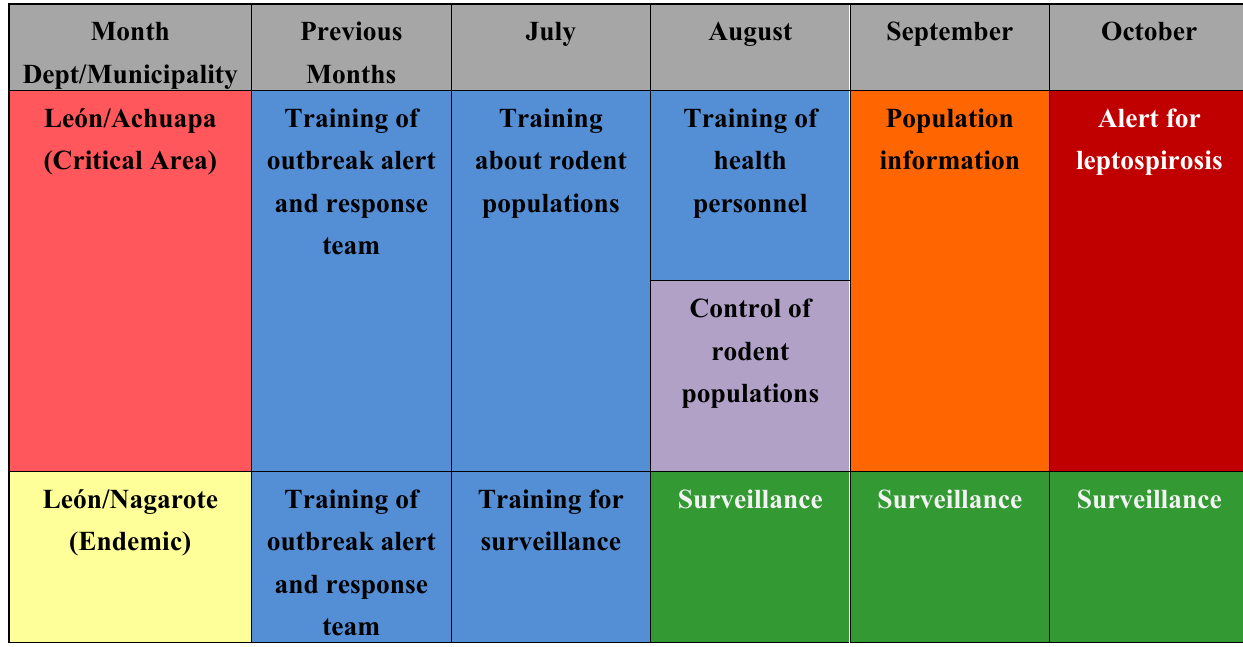
Figure 9. Example of possible use of this information for planning to prevent and respond to leptospirosis outbreaks in the case of